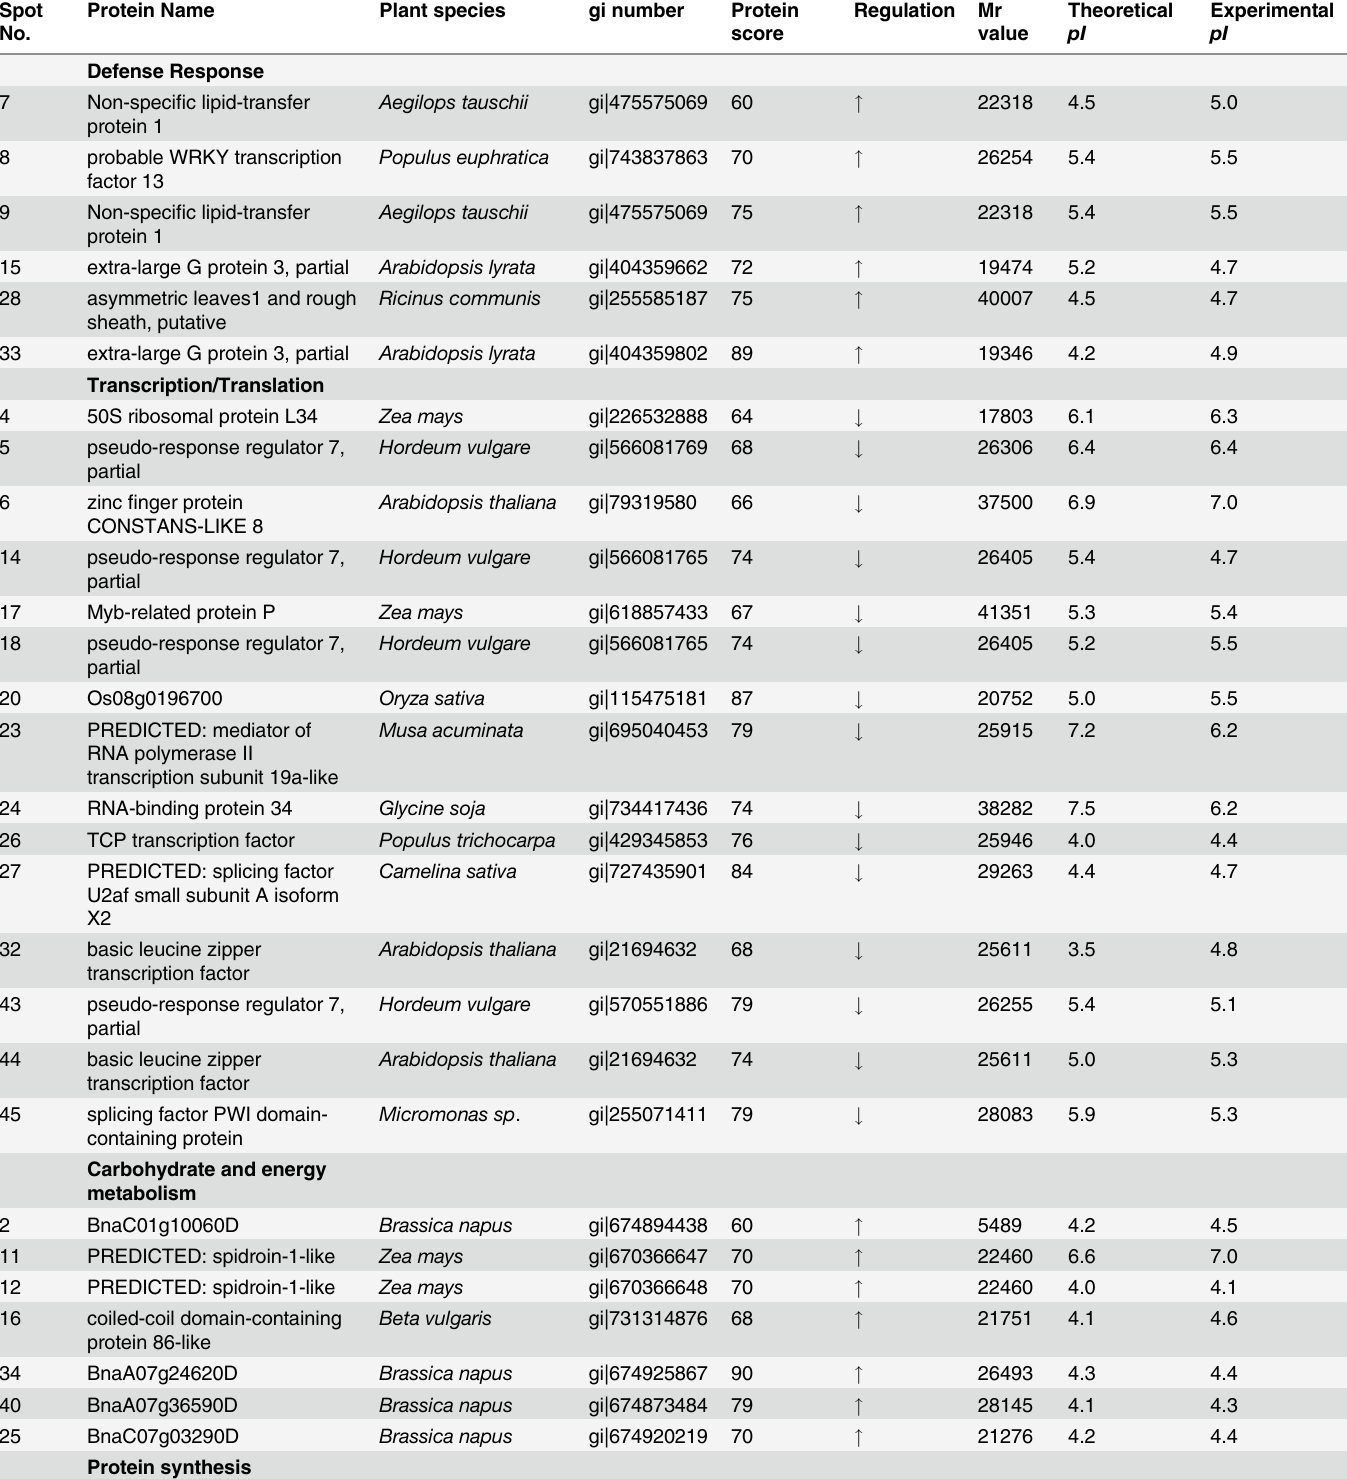
Table 1. Protein identification by MALDI-TOF MS in leaves of tomato ( Solanum lycopersicum L.) under pi starvation. Spot